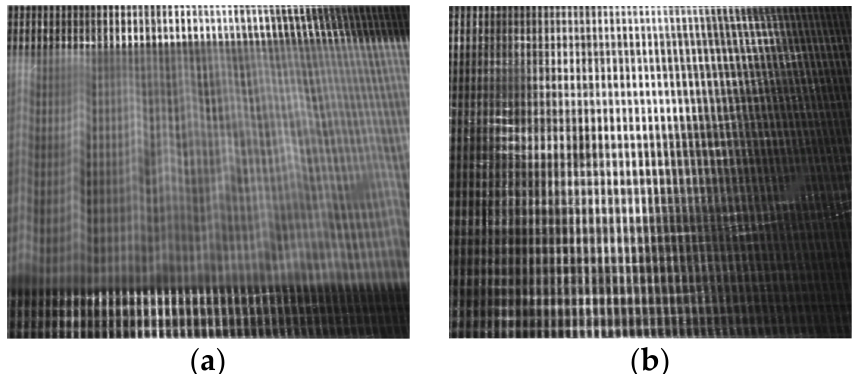
Figure 3. The optical principle of the thickness position conversion: ( a ) experimental image; ( b ) reference image.